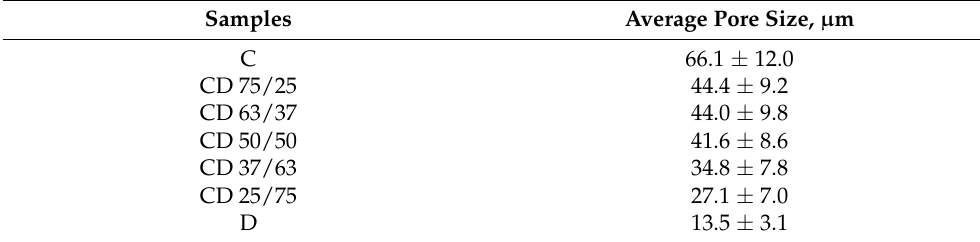
Table 3. The average pore size of the obtained